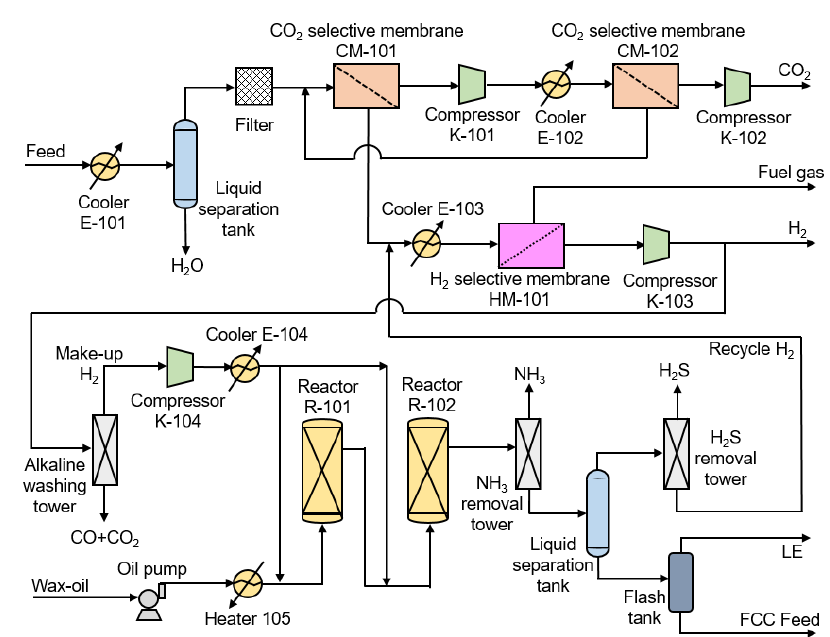
Figure 3. The schematic diagram of the NMGH (Novel Membrane Separation for H 2 / CO 2 of Shifted Syngas Coupled with Gasoil Hydrogenation) process.